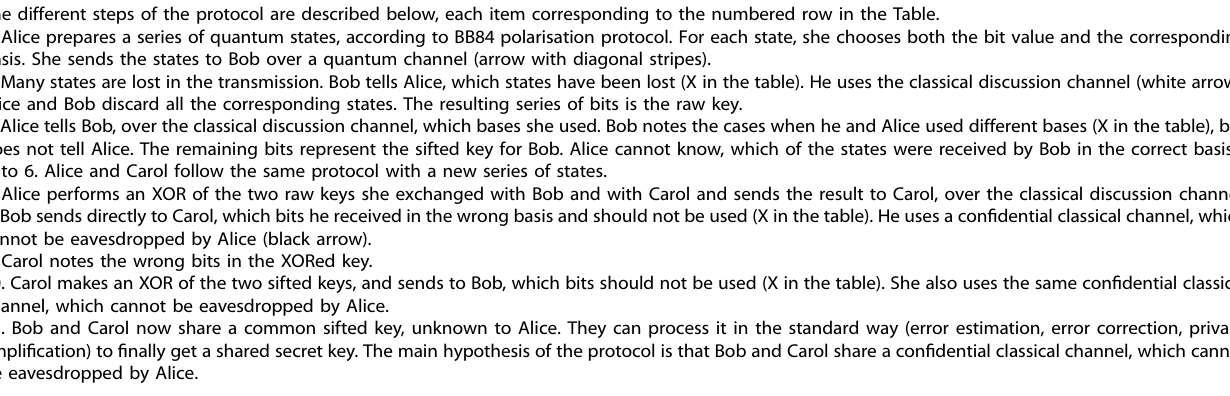
Table 1): Bob fi rst exchanges quantum objects with Alice but does